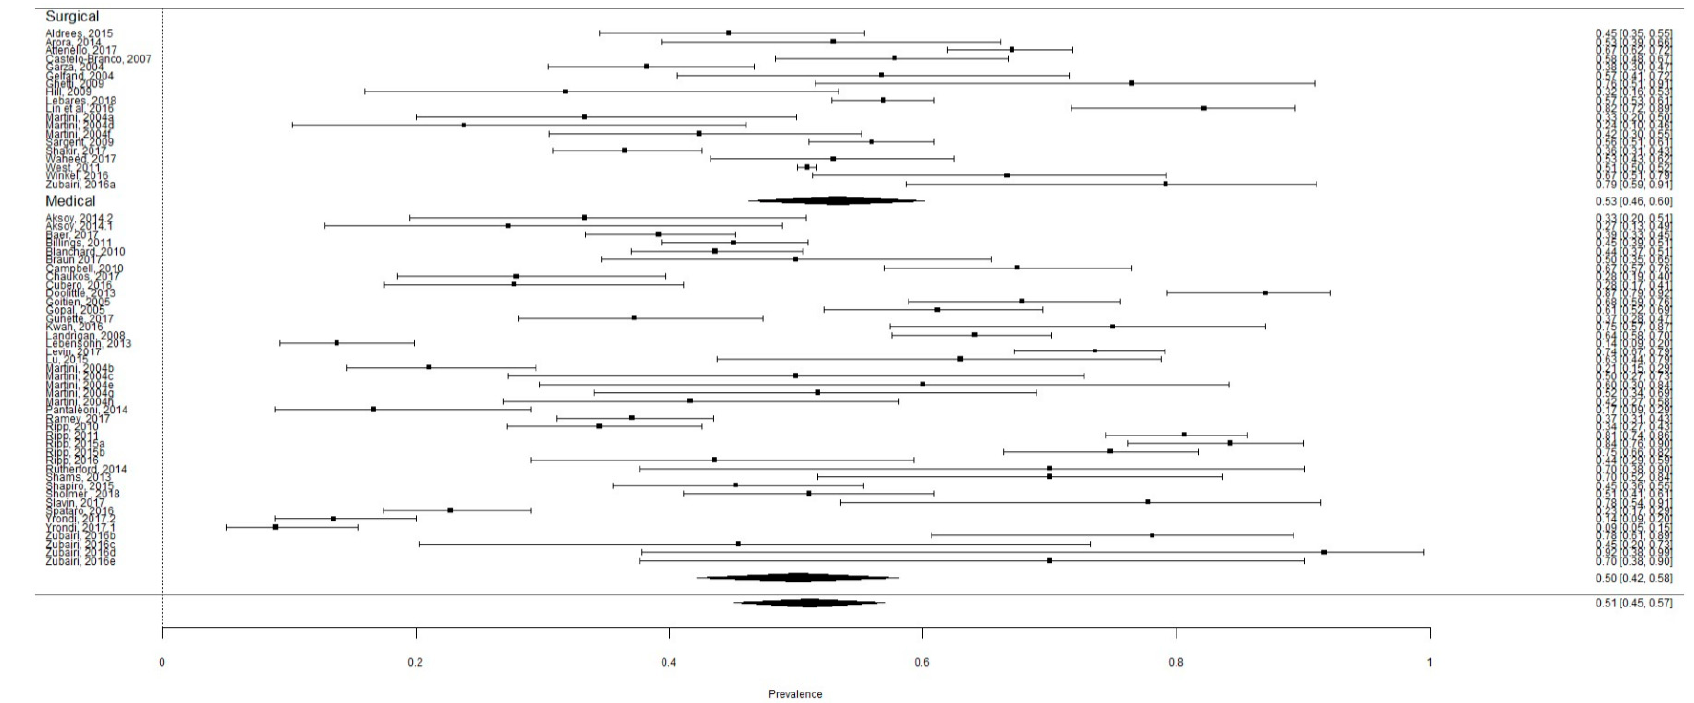
Figure 3. The aggregate prevalence of burnout in medical and surgical residents.